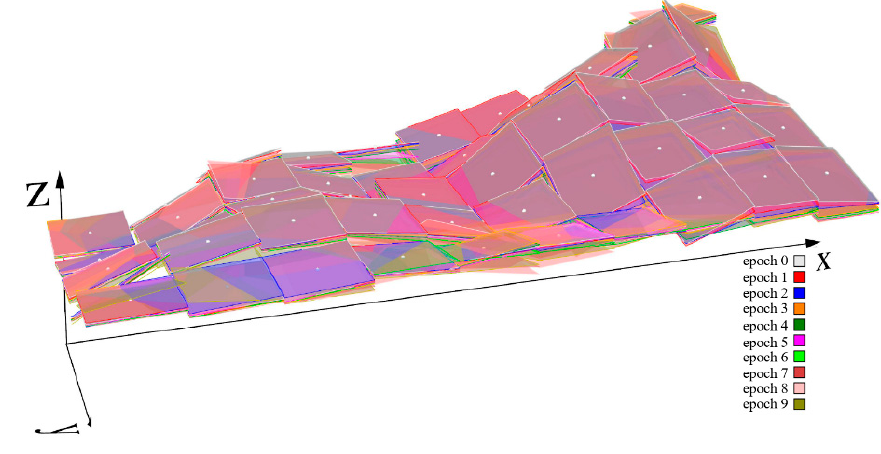
Figure 9. Fitted planes layout for all sectors in every epoch.